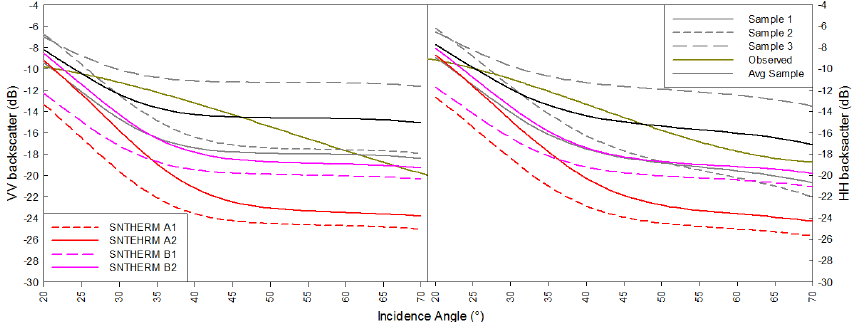
Figure 11. Comparison of simulated MSIB backscatter from samples 1, 2, and 3 and SNTHERM snow outputs A (1,2) and B(1,2). The “Avg Sample” is from samples 1 and 3, representing end members of snow condition. Observed backscatter is a cubic fit, per Fuller et al. (2014).